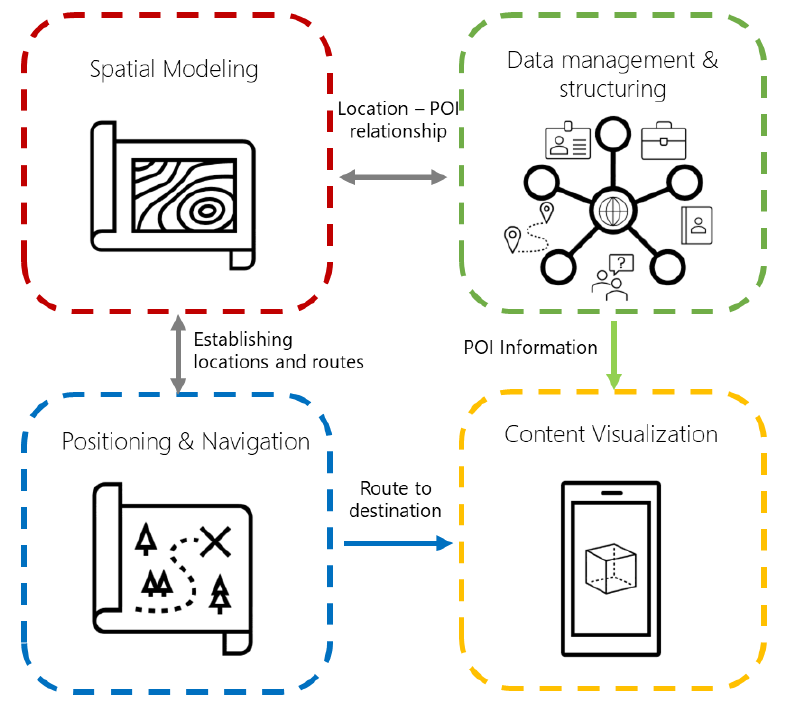
Figure 1. Methodology for developing indoor navigation systems based on AR and Semantic